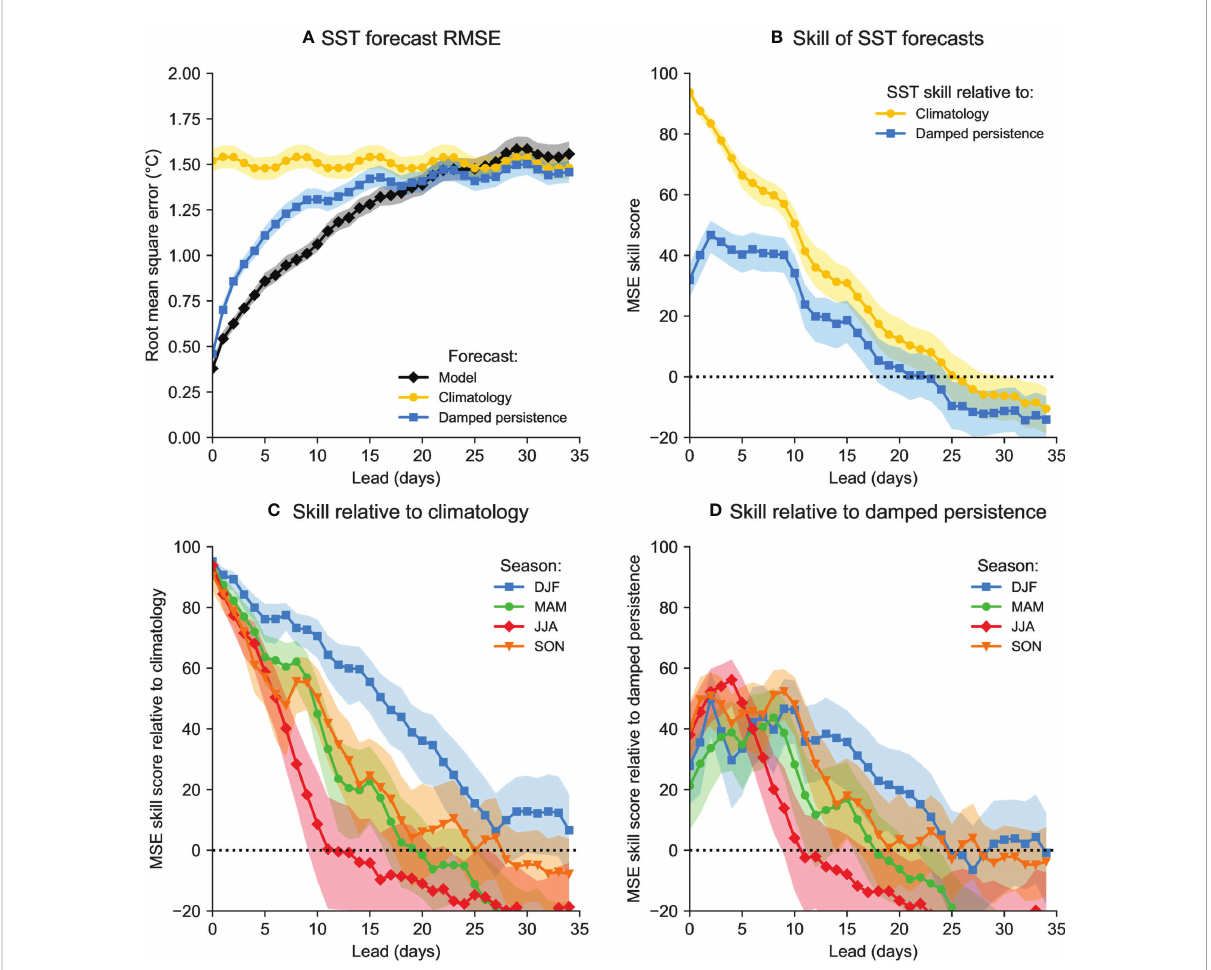
FIGURE 4 (A) Mean square error skill scores for calibrated SST forecasts over all forecast times. (B) MSE skill scores for each season, for the climatology reference forecast. (C, D) MSE skill scores for each season, using climatology (C) and damped persistence (D) as the reference forecasts. In all panels, shaded regions are 90% con fi dence